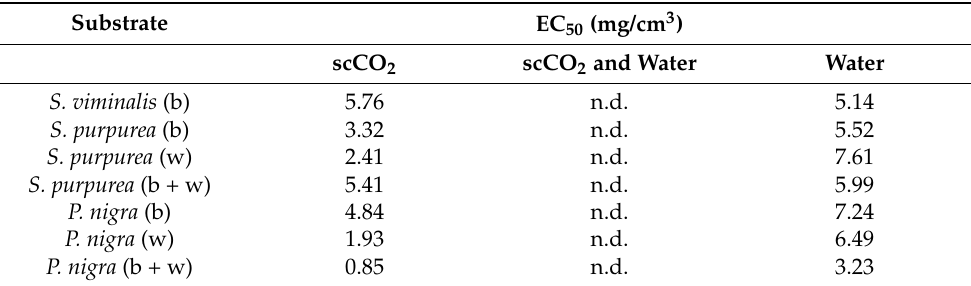
Table 3. The concentration of extracts obtained using: scCO 2 , scCO 2 and water or water, required to chelate 50% of Fe 2+ (EC 50